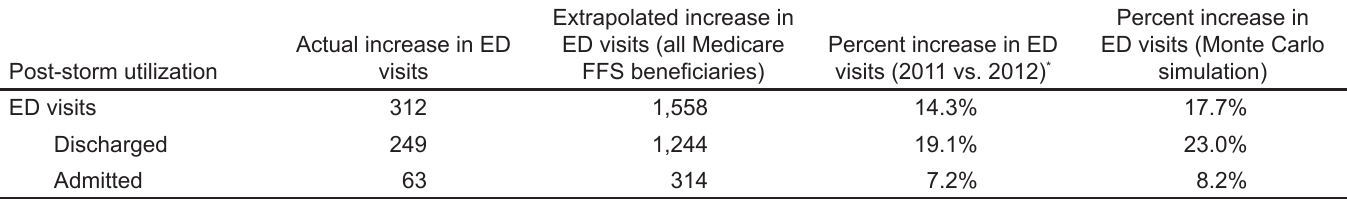
Table 2. Estimated increase in emergency department (ED) utilization among New Jersey Medicare (fee-for-service) FFS beneficiaries by ED disposition in the week after Superstorm Sandy’s